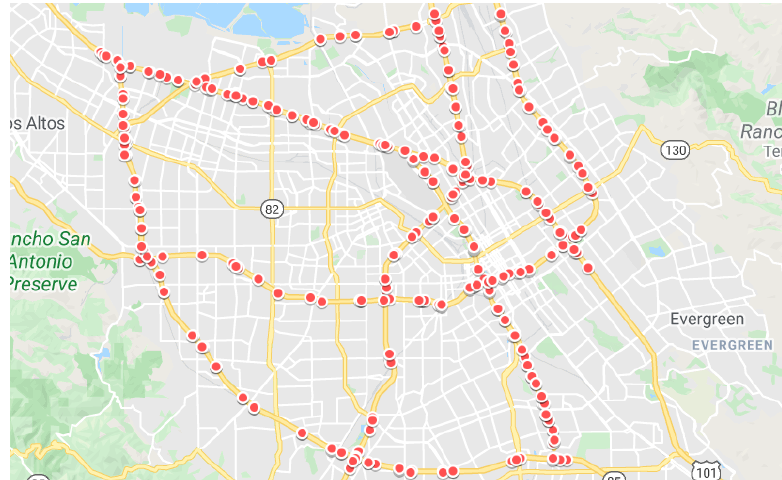
Figure 6. The dataset was collected by the Caltrans Performance Measurement System (PeMS) from from 1 January 2017 to 31 May